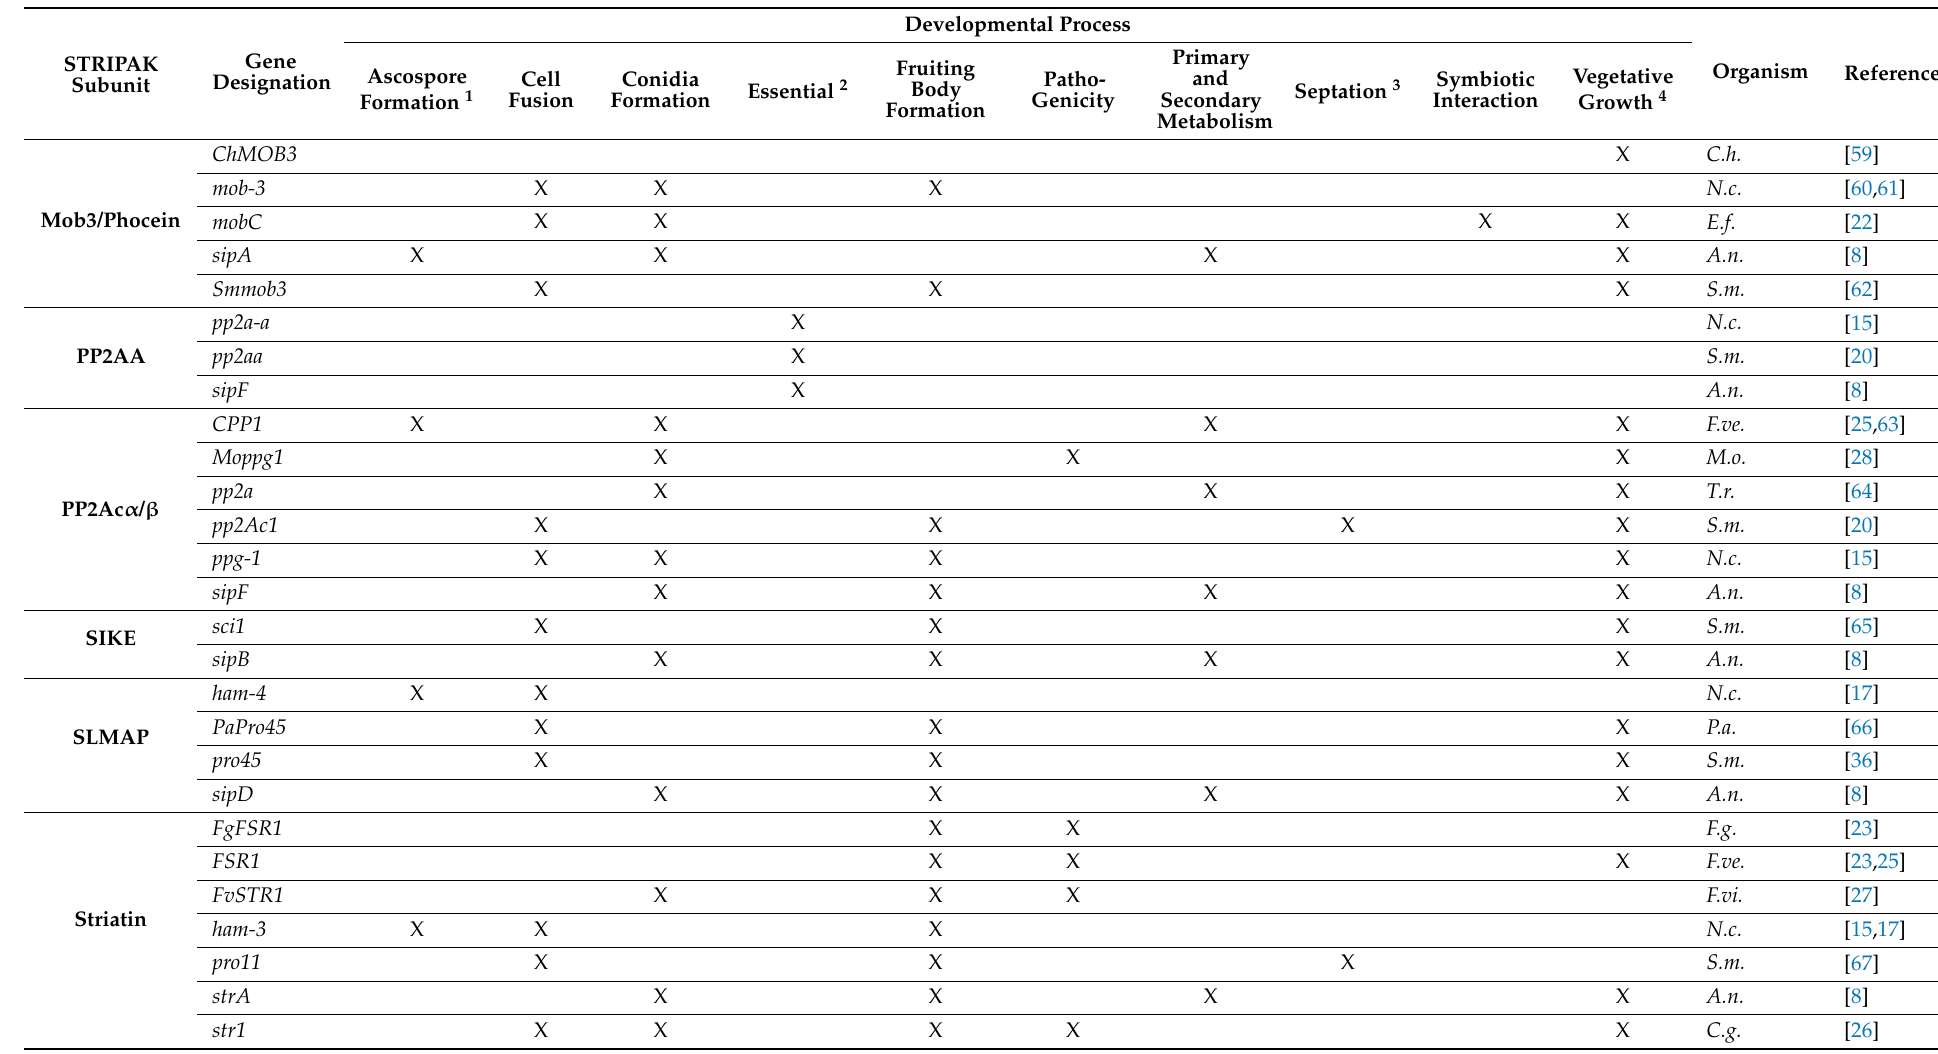
Table 1. List of genes encoding STRIPAK subunits and STRIPAK associated kinases, which are all involved in different developmental processes in euascomycetes.